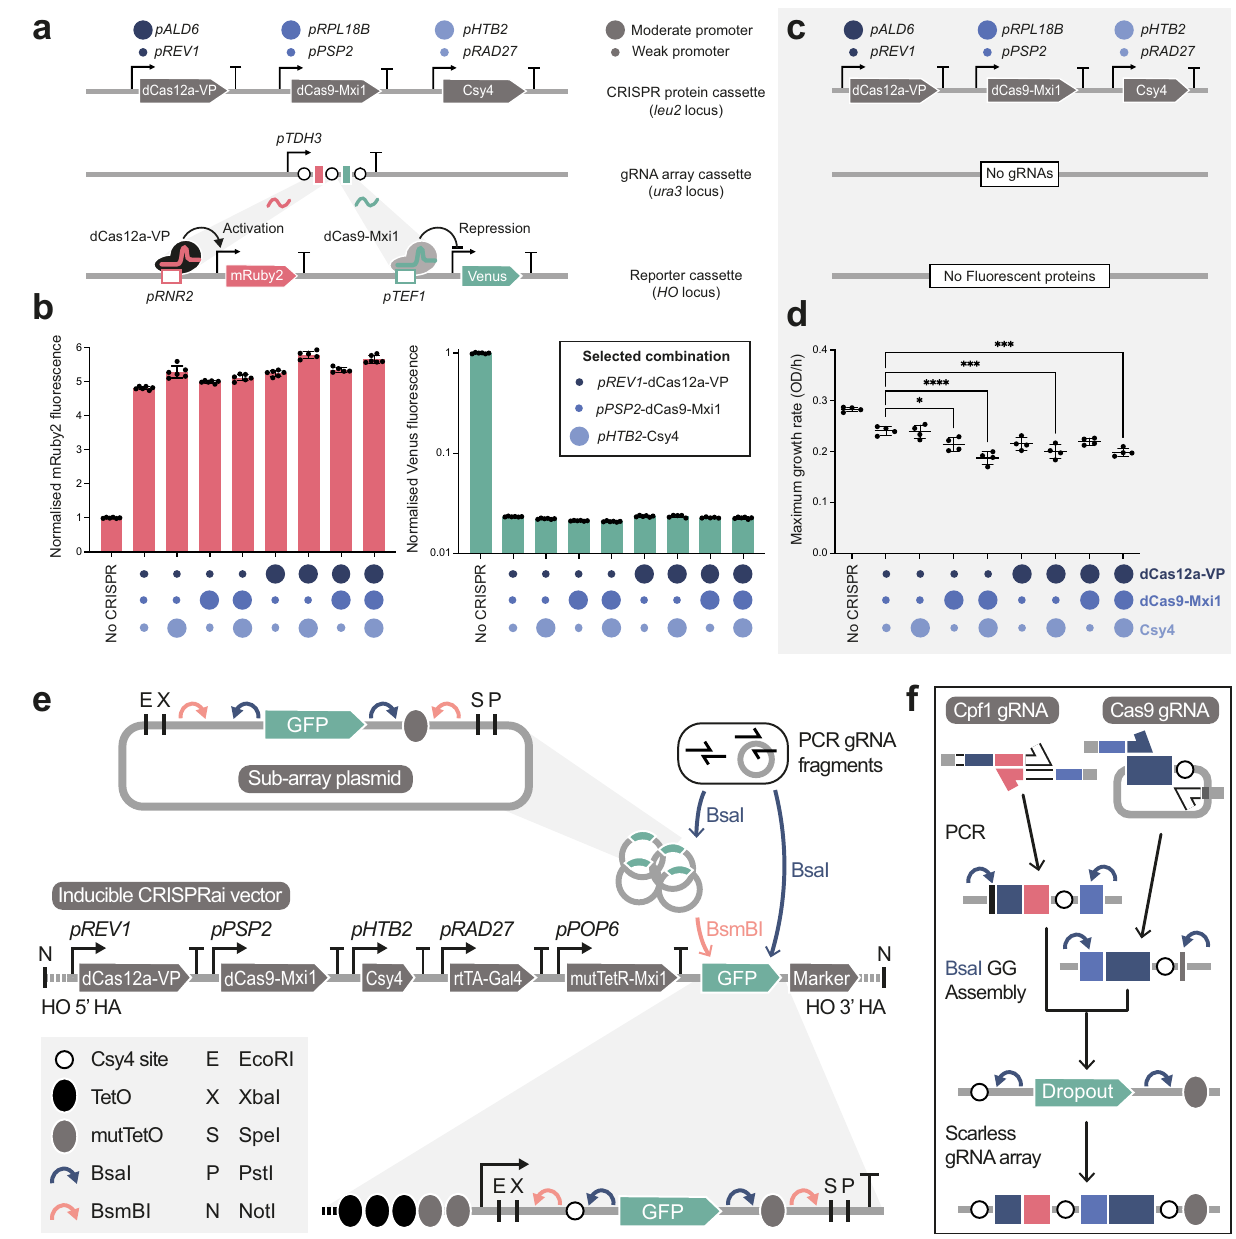
Fig.2|CRISPRproteinexpressionoptimisationandinducibleCRISPRaitoolkit architecture. a + b , Impactof CRISPRai protein expression on gene activation and repression. a Low (small circle) and medium (large circle) strength promoter combinations used to drive the expression of dCas12a-VP (dark blue), dCas9-Mxi1 (blue), and Csy4 (light blue). The constitutive TDH3 promoter was used drive the transcription of an array containing an activation (dCas12a-VP) and repression (dCas9-Mxi1)gRNA targeting the RNR2 and TEF1 promoters driving the expression of mRuby2 and Venus, respectively. b Fluorescence measurements of all mid and low strength promoter-CRISPR protein combinations normalised to a control with no CRISPR proteins (No CRISPR). Experimental measurements are mRuby2 and Venus fl uorescence levels per cell as determined by fl ow cytometry and shown as the mean±SD from six biological replicates. c + d , Impact of CRISPRai protein